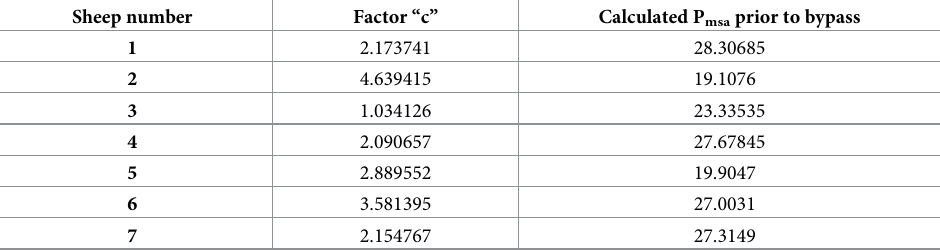
Table 5. Calculated factor “c” and P msa prior to the cardiopulmonary bypass. Sheep